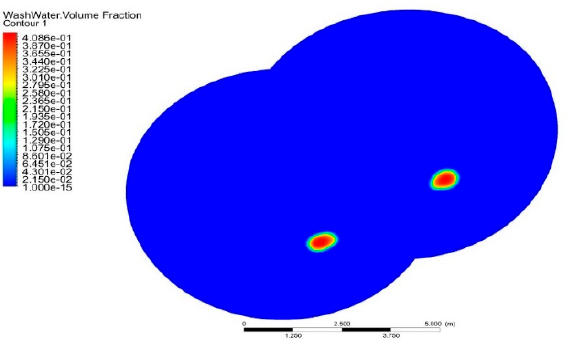
Figure 7. Maximum Volume Fraction values for the Scrubber Wash Water (refined mesh).